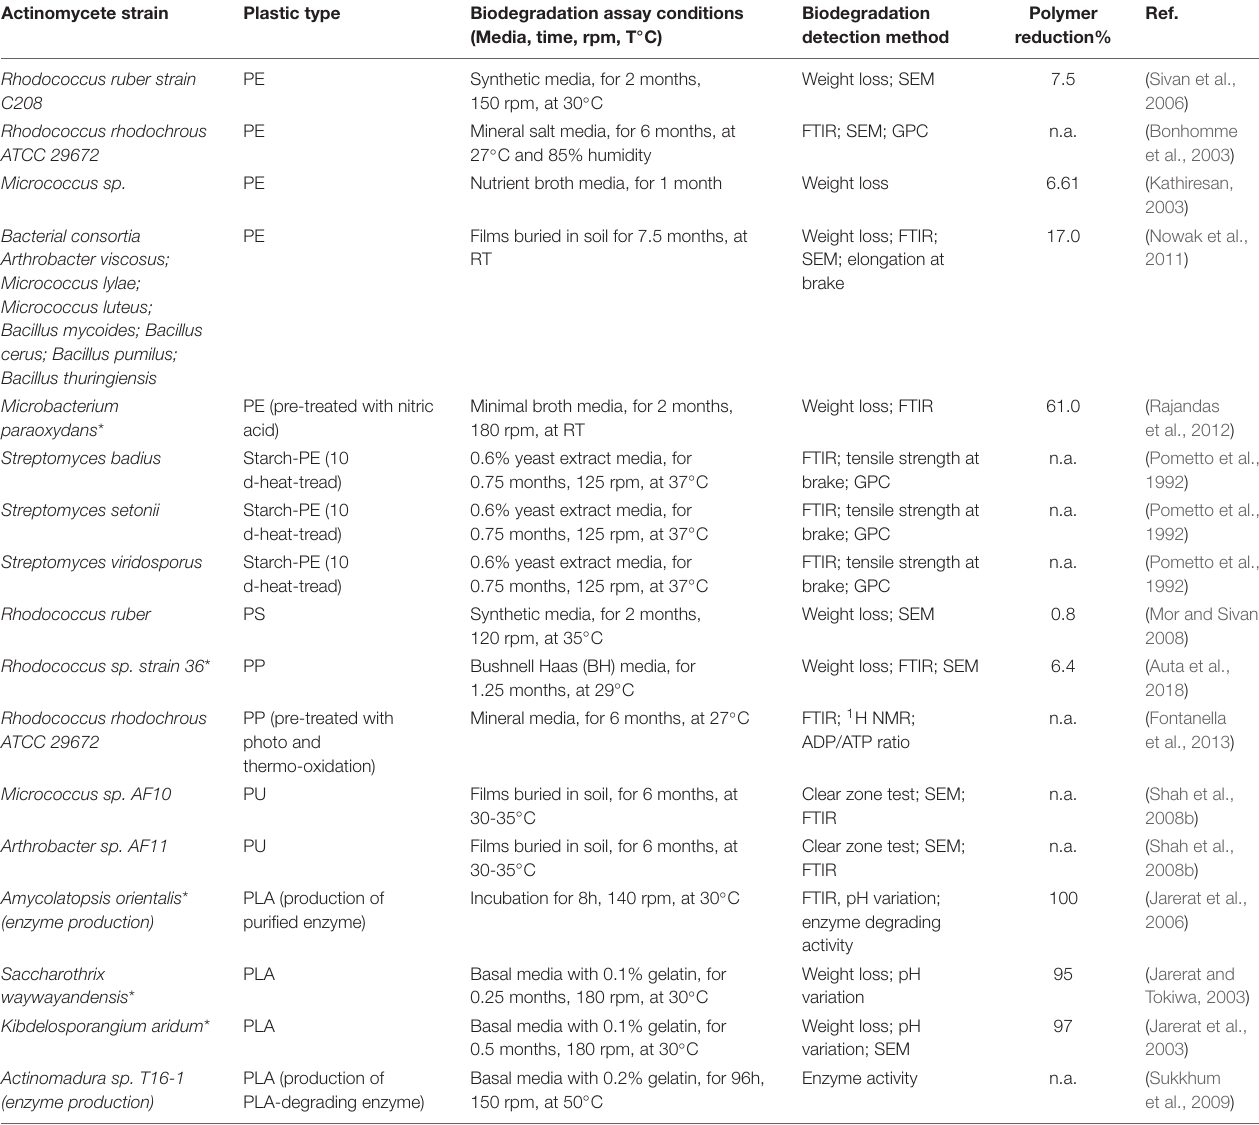
TABLE 3 | Plastics degraded by actinomycetes, biodegradation assay conditions, and used detection